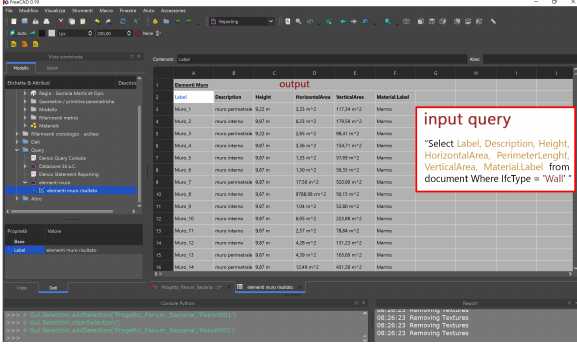
Figure 10 . SQL query related to principal information (description; height; areas; materials) of Wall elements of the Domus Regia